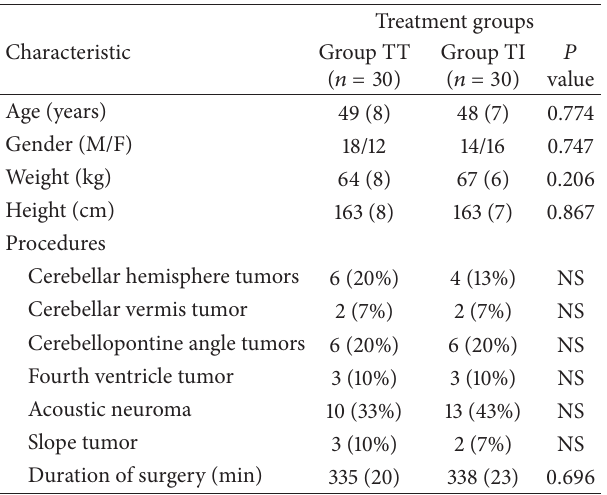
Values are given as Mean ± SD, or number of patients (%). Group TT: tracheal tube intubation group; Group TI: I-gel facilitated endotracheal tube intubation